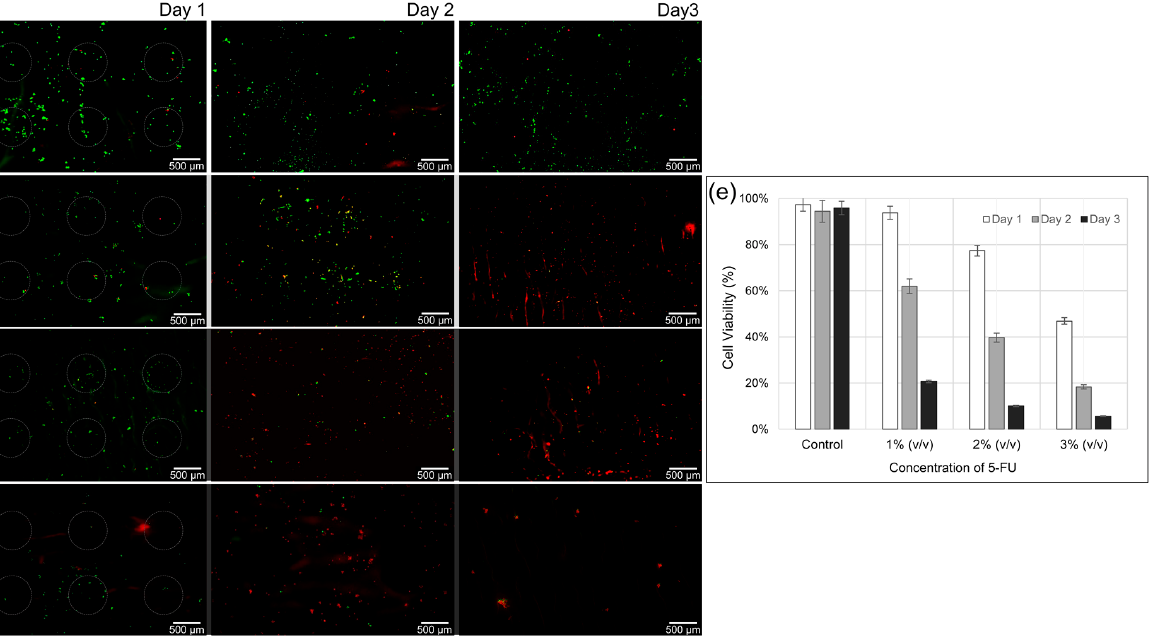
Figure 8. Live/dead assay images of YD-10B cells on a bilayer membrane containing HA hydrogel array. ( a ) Control group, ( b ) concentration of 1% ( v/v ) 5-FU ( c ) concentration of 2% ( v/v ) 5-FU, ( d ) concentration of 5% ( v/v ) 5-FU, and ( e ) viability of YD-10B cells on a bilayer membrane containing HA hydrogel array.